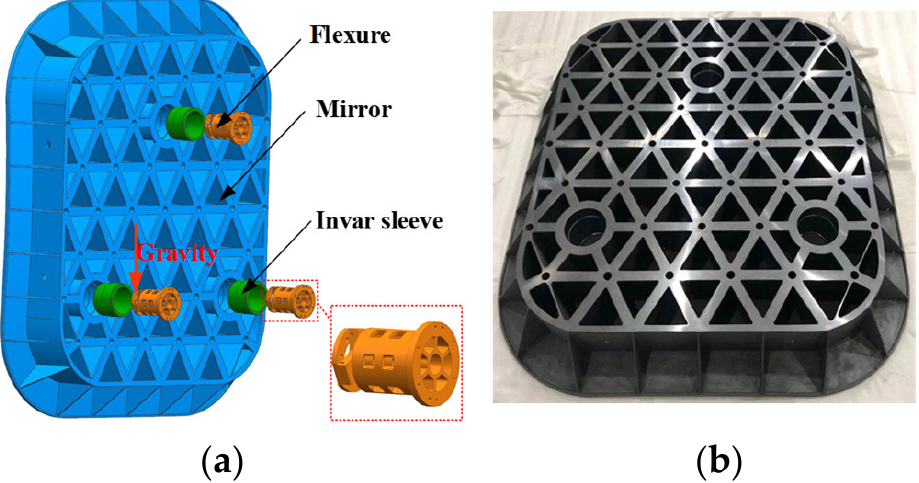
Figure 3. ( a ) Exploded view of predesigned lightweight mirror assembly showing the symmetries, invar sleeve, gravity orientation, and illustration of the adopted flexure configuration. ( b ) The square SiC mirror under milling. Table 1. The performance and constraints of the mirror assembly under different operating condi- tions.